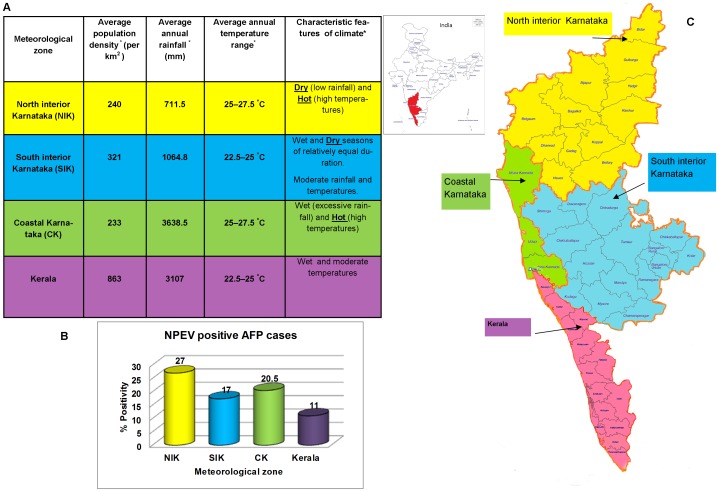
Meteorological zone wise analysis of NPEV positivity in AFP cases of the present study.
(A) Demographic and climatological factors of different meteorological zones of south-western India. *Retrieved from [25], [26], [27], [28], [39]. (B) Meteorological zone wise NPEV positivity. (C) Map of different meteorological zones of Karnataka and Kerala states of south-western India.